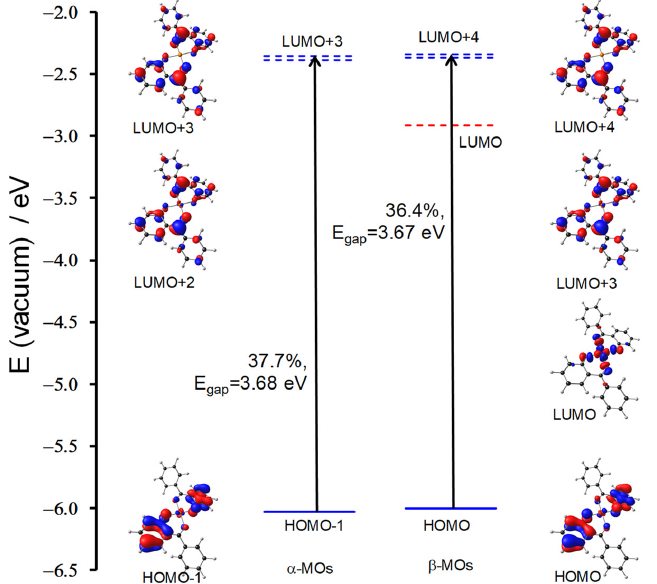
Figure 5. B3LYP/6-311G(d,p)/def2-TZVPP calculated Kohn − Sham MO energy level diagram illustrating the main MO transitions involved in the calculated peak at 401.2 nm, corresponding to the experimental peak at 401 nm, of (5): (i) HOMO-1 to LUMO + 3 and (ii) HOMO to LUMO + 4. The energy of occupied and unoccupied MO energy levels is shown with solid and dotted lines, respectively. Mainly copper-d-based and ligand-based MOs are shown in red and blue, respectively. Selected MOs are visualized. A contour of 0.06 e/Å 3 was used for the orbital plot. Colour code of atoms (online version): Cu (orange), C (grey), O (red), H (white).